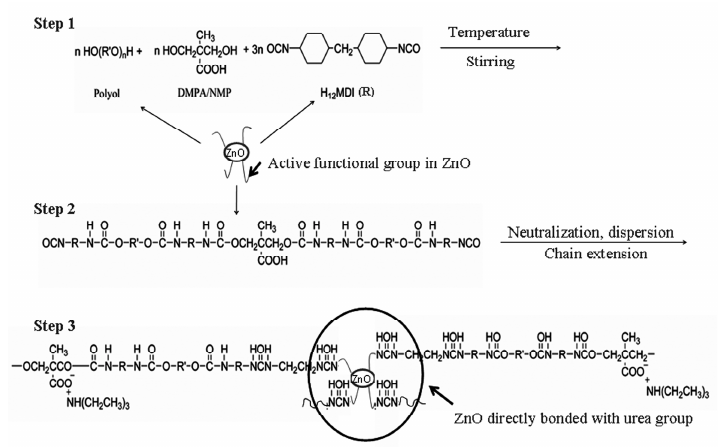
Table 2. Mixing of pristine ZnO during PU/ZnO dispersion preparation.